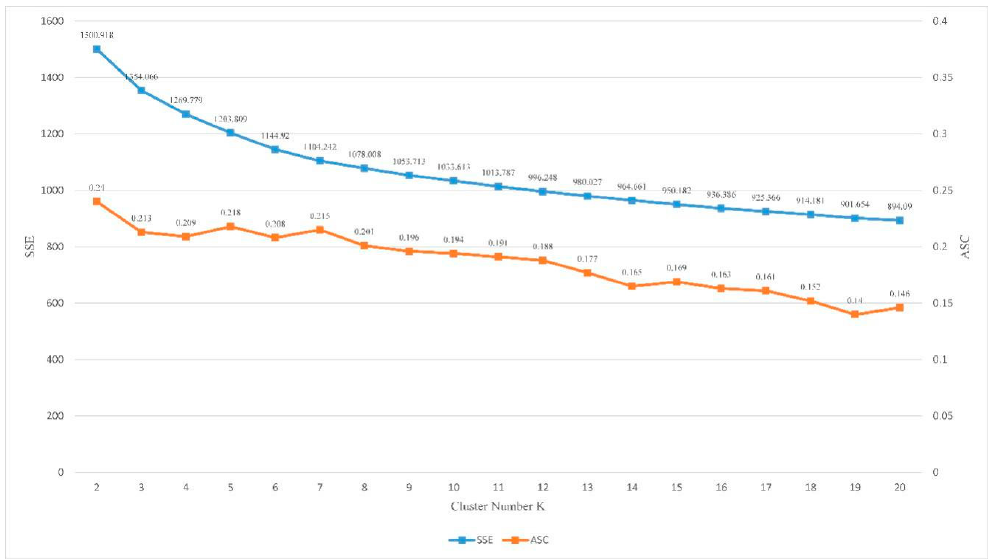
Figure 6. Change of average silhouette value (left y-axis) and error square sum (right y-axis) of clustering results (POI vectors) with increases of K value (x-axis).